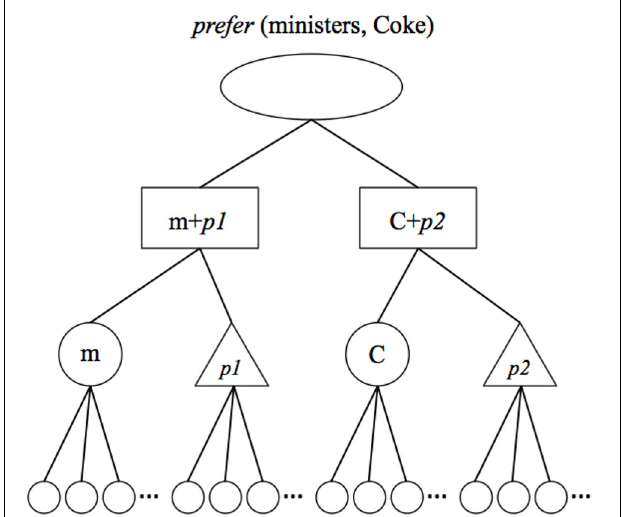
FIGURE 1 | LISA representation of the proposition prefer (ministers, Coke). Semantic units (small circles) represent the semantic features of objects and relational roles. Object and role units (large circles and triangles, respectively) represent objects, such as ministers (M) and Coke (C), and relational roles, such as prefer-agent ( p1 ) and preferred-thing ( p2 ), in a localist fashion. Sub-proposition (SP; aka role-binding ) units (rectangles) represent bindings of arguments (objects or complete propositions) to relational roles and proposition (P) units (oval) represent complete propositions. When a proposition becomes active (i.e., enters working memory), role-filler bindings are represented by synchrony of firing: Separate role bindings (SPs, object, role and their associated semantic units) fire out of synchrony with one another, and units representing the same role binding fire in synchrony with one